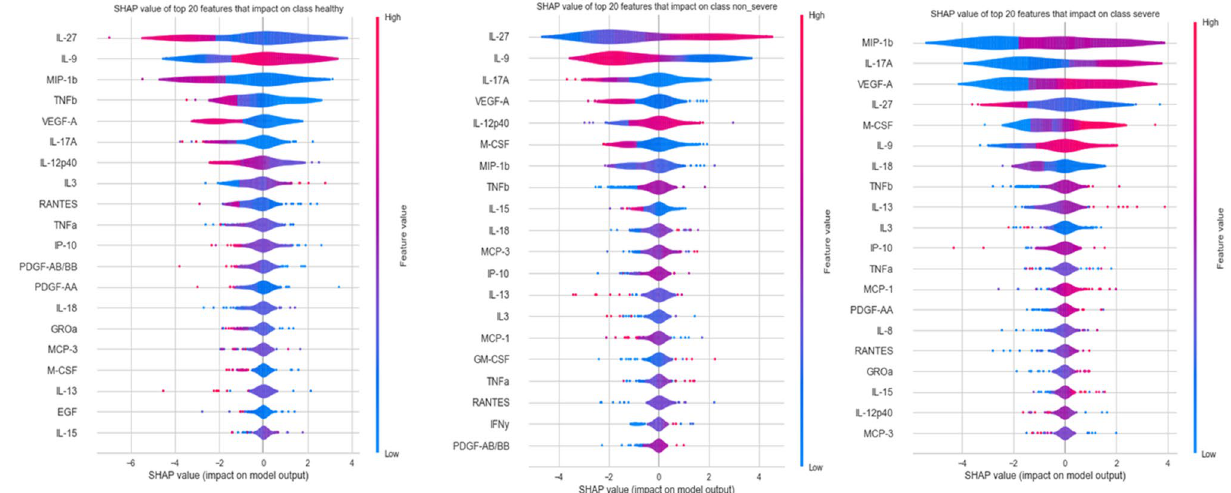
Figure 13. Examples of SHAP values computed for individuals’ predictions (local explanations) for Healthy, Non-Sever, and Sever patients.